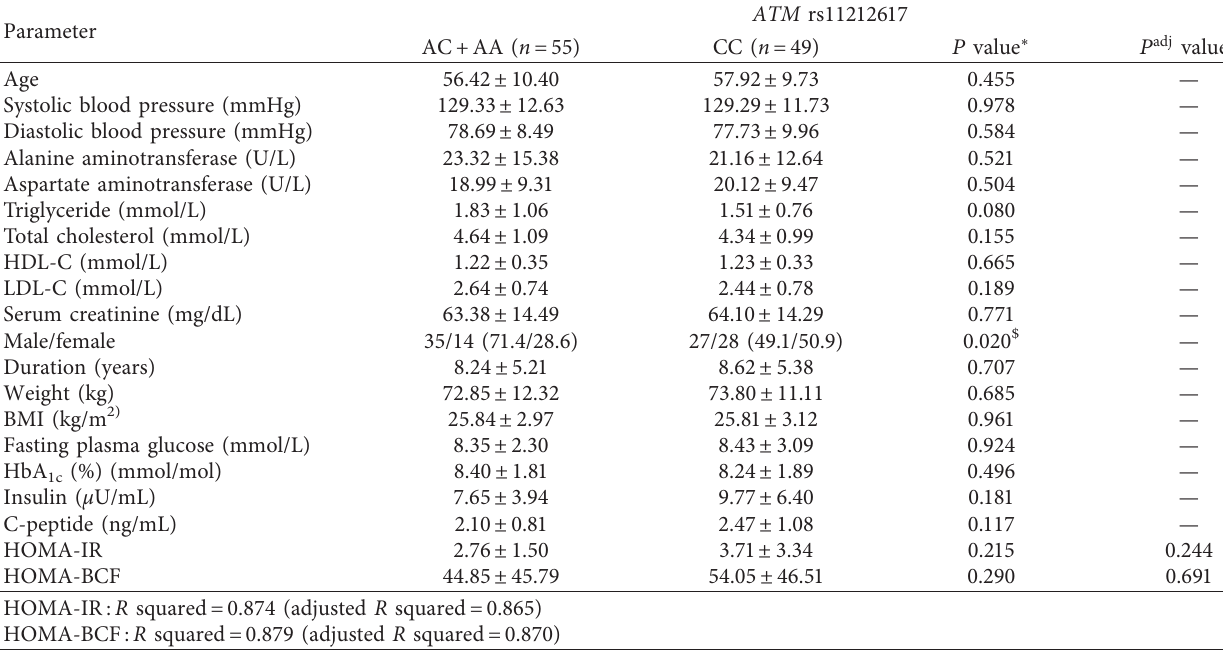
Table 2: Clinical characteristics of the subjects according to the genotypes of ATM rs11212617.